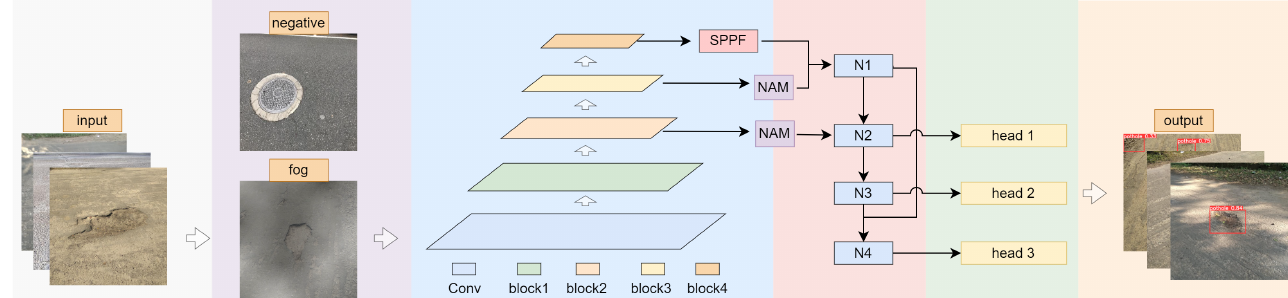
Figure 2. Framework of the